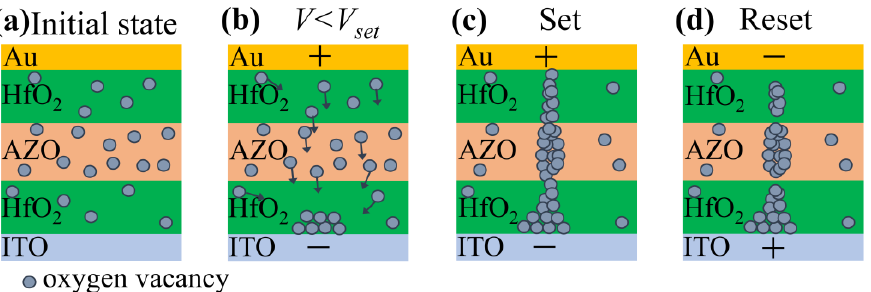
Figure 7. ( a ) Conduction model of the Au/HfO 2 /Al-ZnO/HfO 2 /ITO device with oxygen vacancies distributed in the insulating layer in the initial state, ( b ) oxygen vacancies move towards the ITO bottom electrode, ( c ) applied voltage greater than V set on the top electrode and oxygen vacancies form conductive filaments, and ( d ) applied negative voltage to the electrode and broken conductive filament.